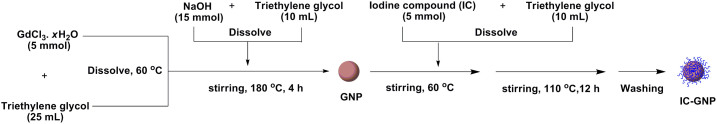
One-pot synthesis.One-pot synthesis procedure for four IC-GNP samples.